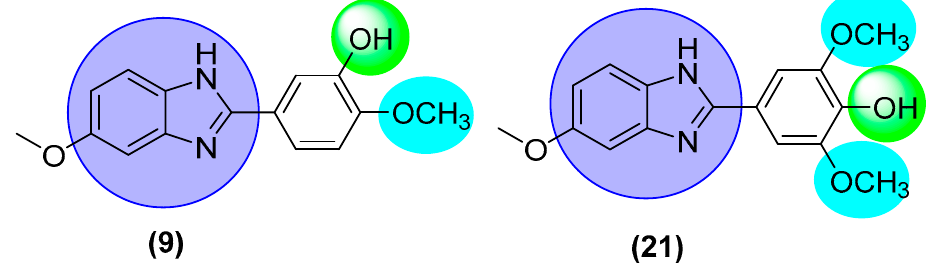
Figure 10. SAR studies of compounds 9 and 21 .